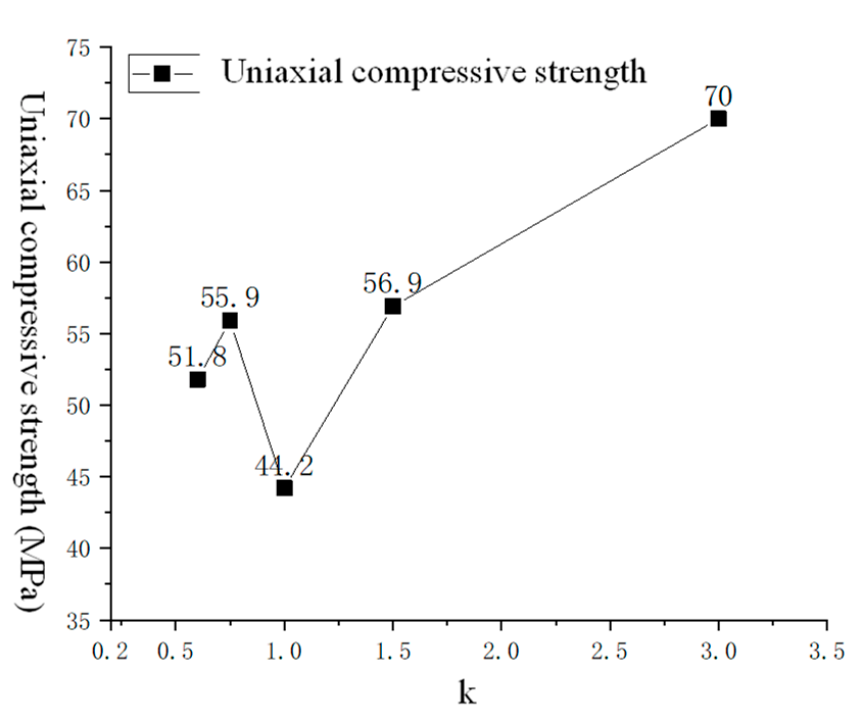
Figure 4. Trend chart of uniaxial compressive strength changing with k.